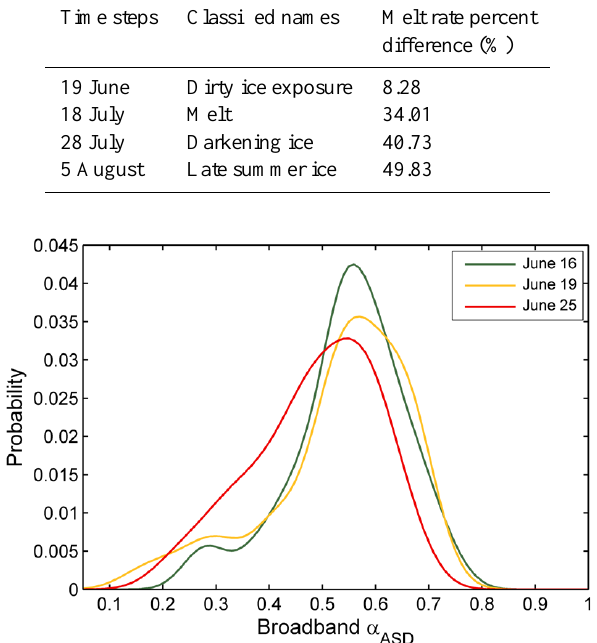
Figure 5. Observed distributions of high-quality broadband α ASD transects on 16, 19, and 25 June.